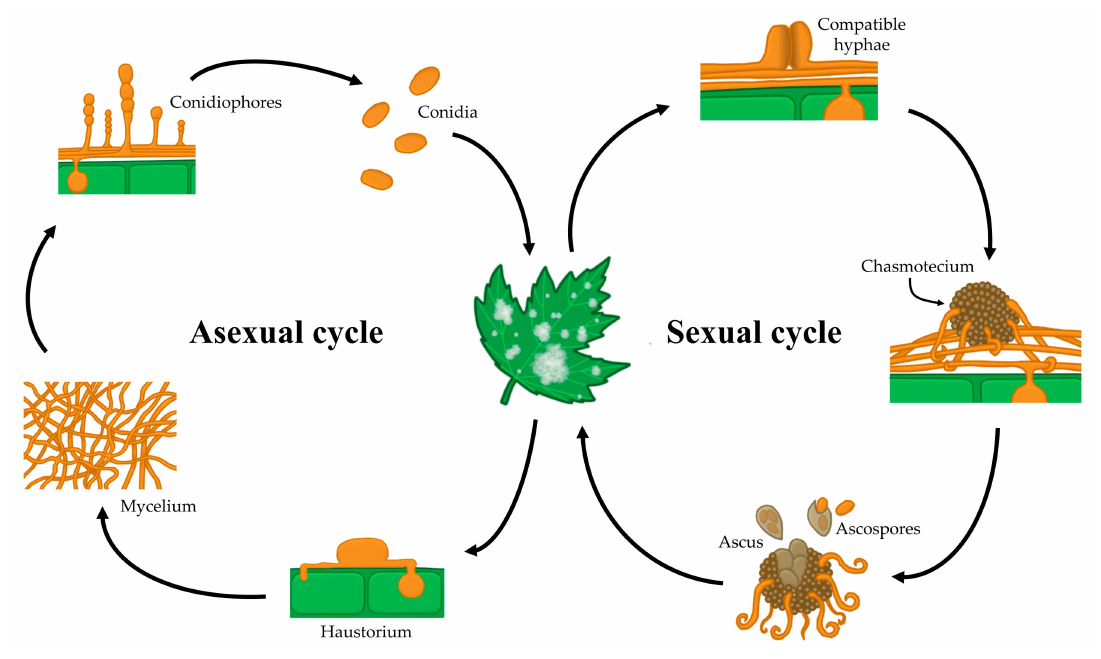
Figure 2. Typical life cycle of powdery mildew